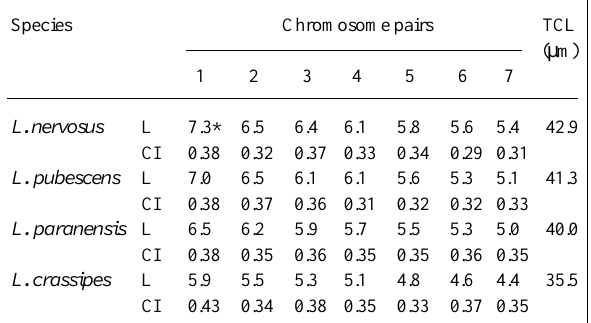
Table II - Average chromosome lengths in m m (L), centromeric indices (CI) and total complement length (TCL) of four Lathyrus species.